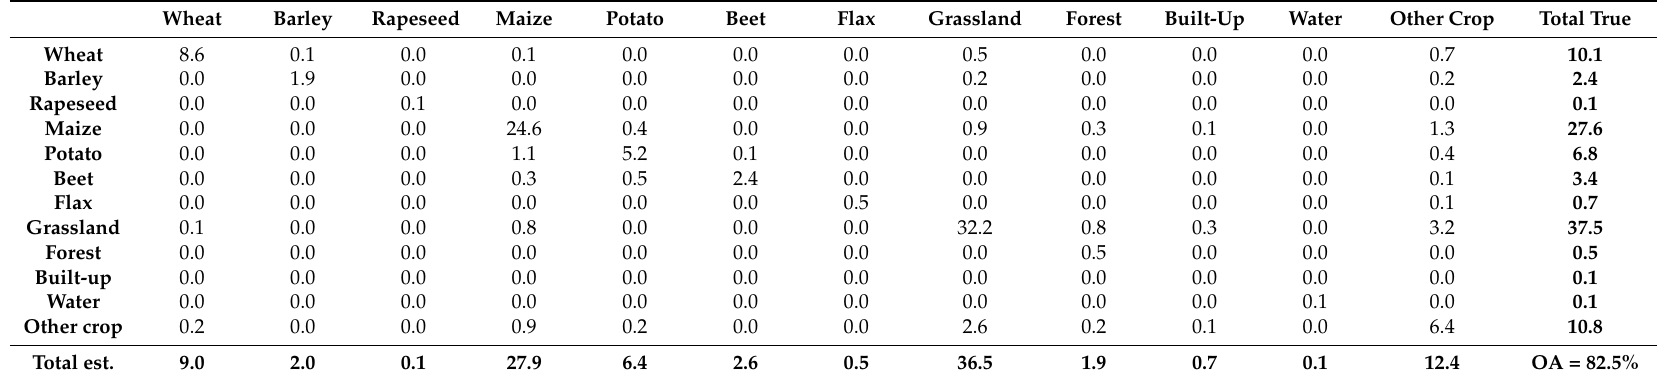
Table 4. Confusion matrix for final mapping in August 2017 using Sentinel-1 and -2 inputs. Small differences in “total true” and “total estimated” between Tables 3 and 4 are due to